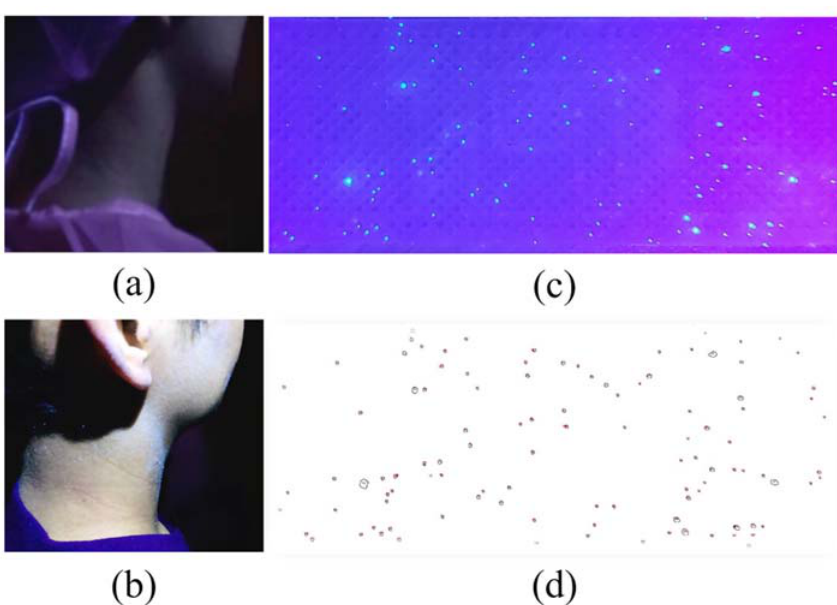
Figure 4. Using the protection tent could decrease contaminations over the front and back body regions of medical personnel pre-doffing and post-doffing personal protective equipment. Photos of medical personnel with ( a ) and without ( b ) use of the tent were provided. ( c ) A photo of the fluorescent particles on the floor was obtained. ( d ) ImageJ was used to analyze the fluorescent particles.